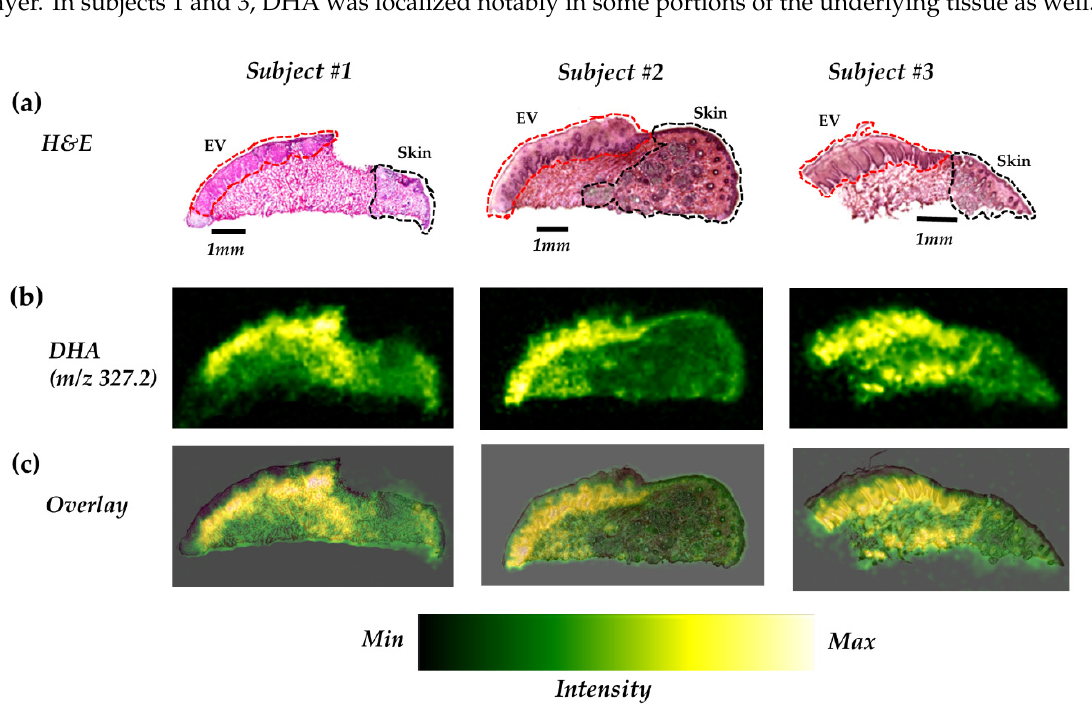
Figure 4. DHA is highly distributed in the epithelium of the vermilion (EV). ( a ) H&E images of lip sections, ( b ) representative DESI–MSI ion images for DHA of the human lip in negative ion mode, and ( c ) transparent overlaid images for DHA and H&E. The skin and EV areas are indicated by black and red lines, respectively, in the H&E images. The area below the EV (not indicated) is the underlying tissue of the vermilion.